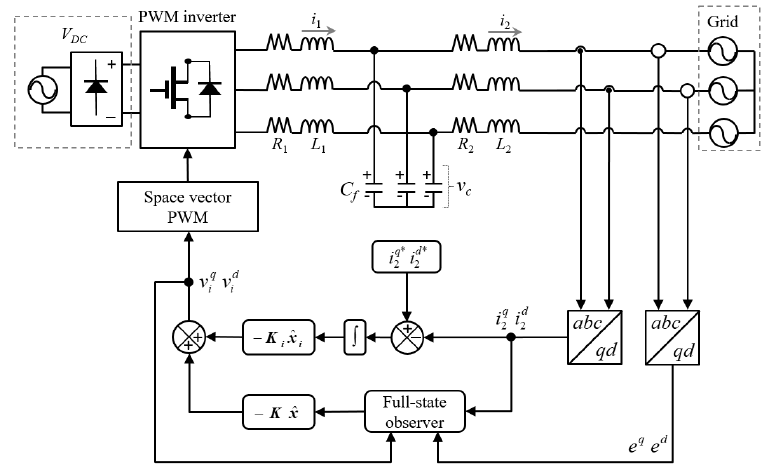
Figure 3. Control block diagram of the proposed integral state feedback control scheme in the discrete-time domain.